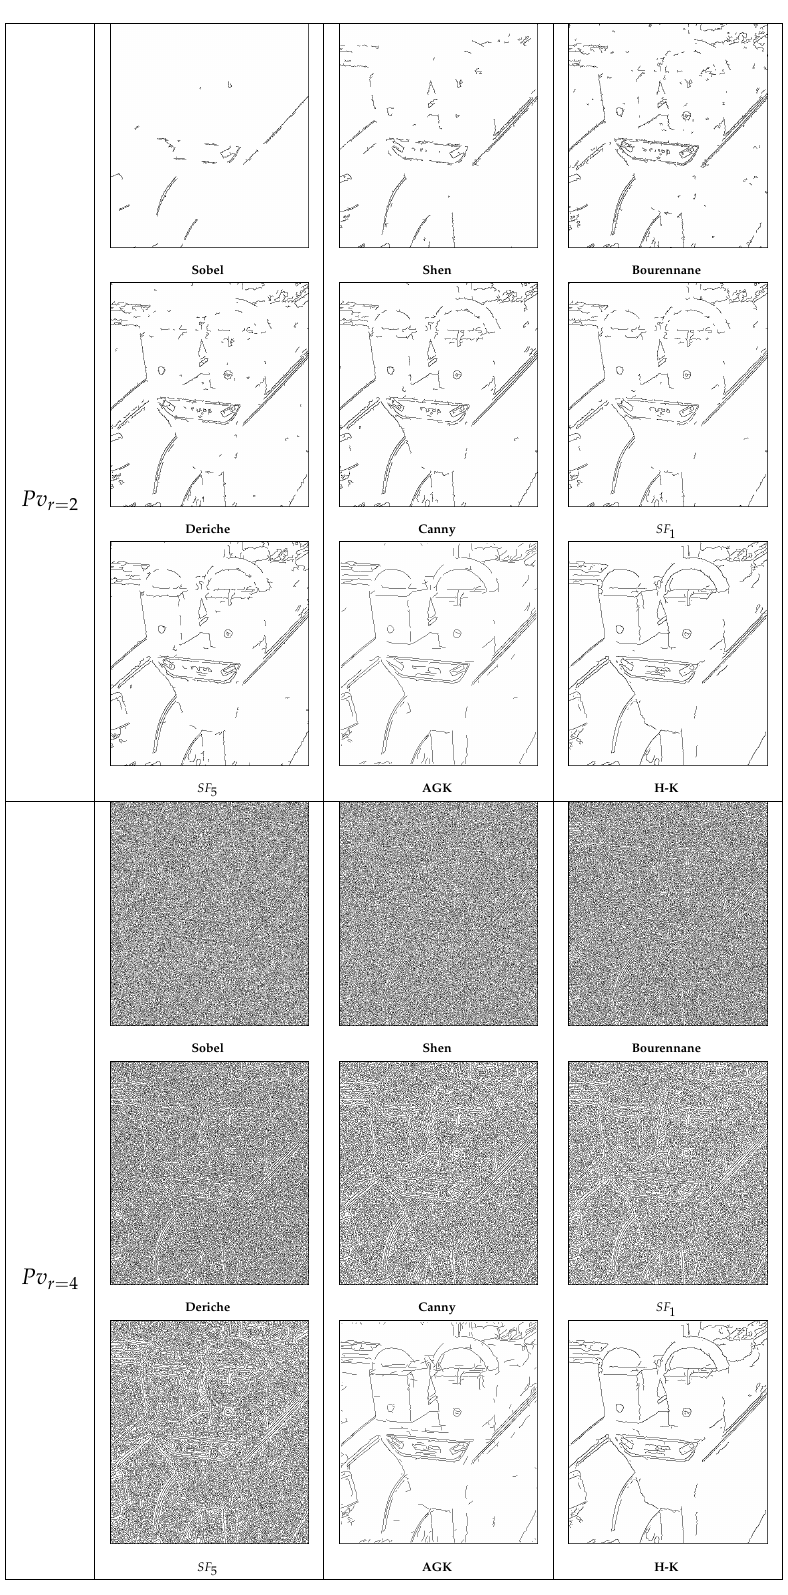
Figure 38. Ideal segmentations for several edge detectors on image parkingmeter, PSNR = 14